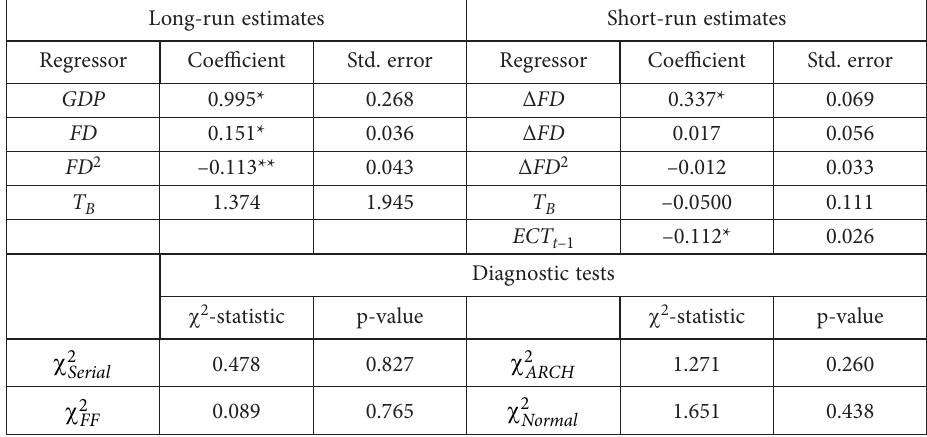
Table 8. The results for ARDL-ECM (3,3,0,0,1)